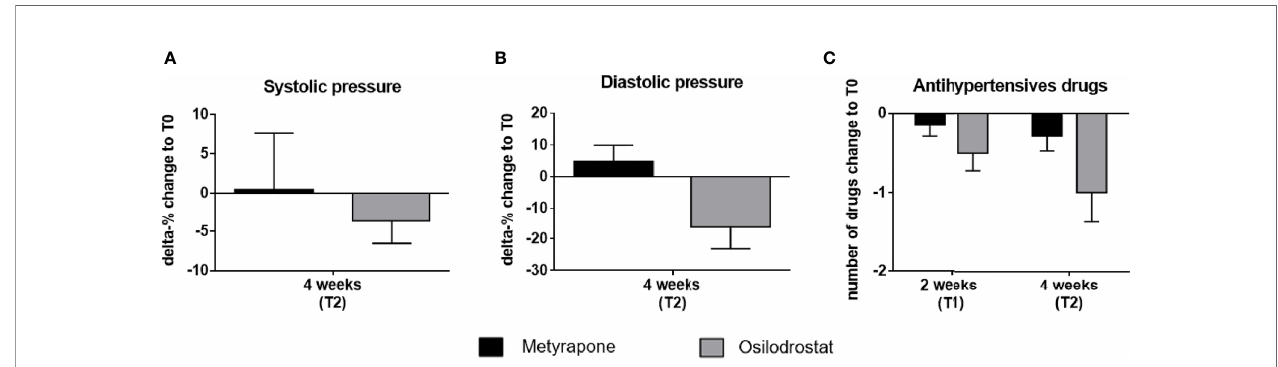
FIGURE 3 | Delta percentage of systolic and diastolic blood pressure and change in number of antihypertensive drugs under metyrapone or osilodrostat treatment during follow-up compared with baseline. Changes in percentage from T0 (baseline) of (A) systolic, (B) diastolic blood pressure after 4 weeks (T2) of metyrapone or osilodrostat therapy compared with baseline (T0). (C) Changes in number of anti-hypertensive drugs after two weeks (T1) and 4 weeks (T2) of treatment in comparison to